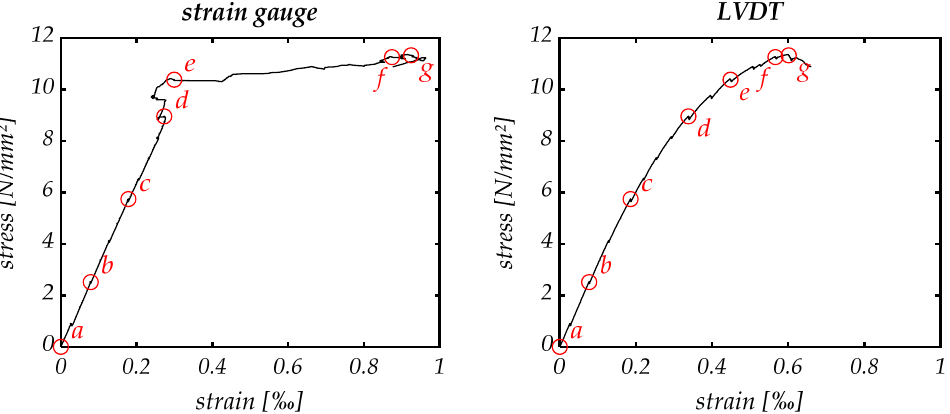
Figure 12. Stress–strain curve of tensional test displaying the mean of four strain gauges ( left ) and three LVDTs ( right ). The red circles ( a – g ) mark the stages where pictures were taken for DIC evaluation.